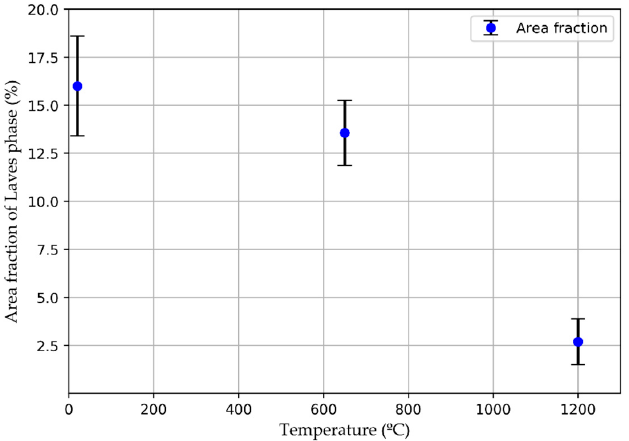
Figure 12. SEM analysis on the facture sections of the WAAM samples at various temperature ( a ) Room temperature 20 °Ϲ ; ( b ) 650 °Ϲ ; ( c ) 1200 °Ϲ .